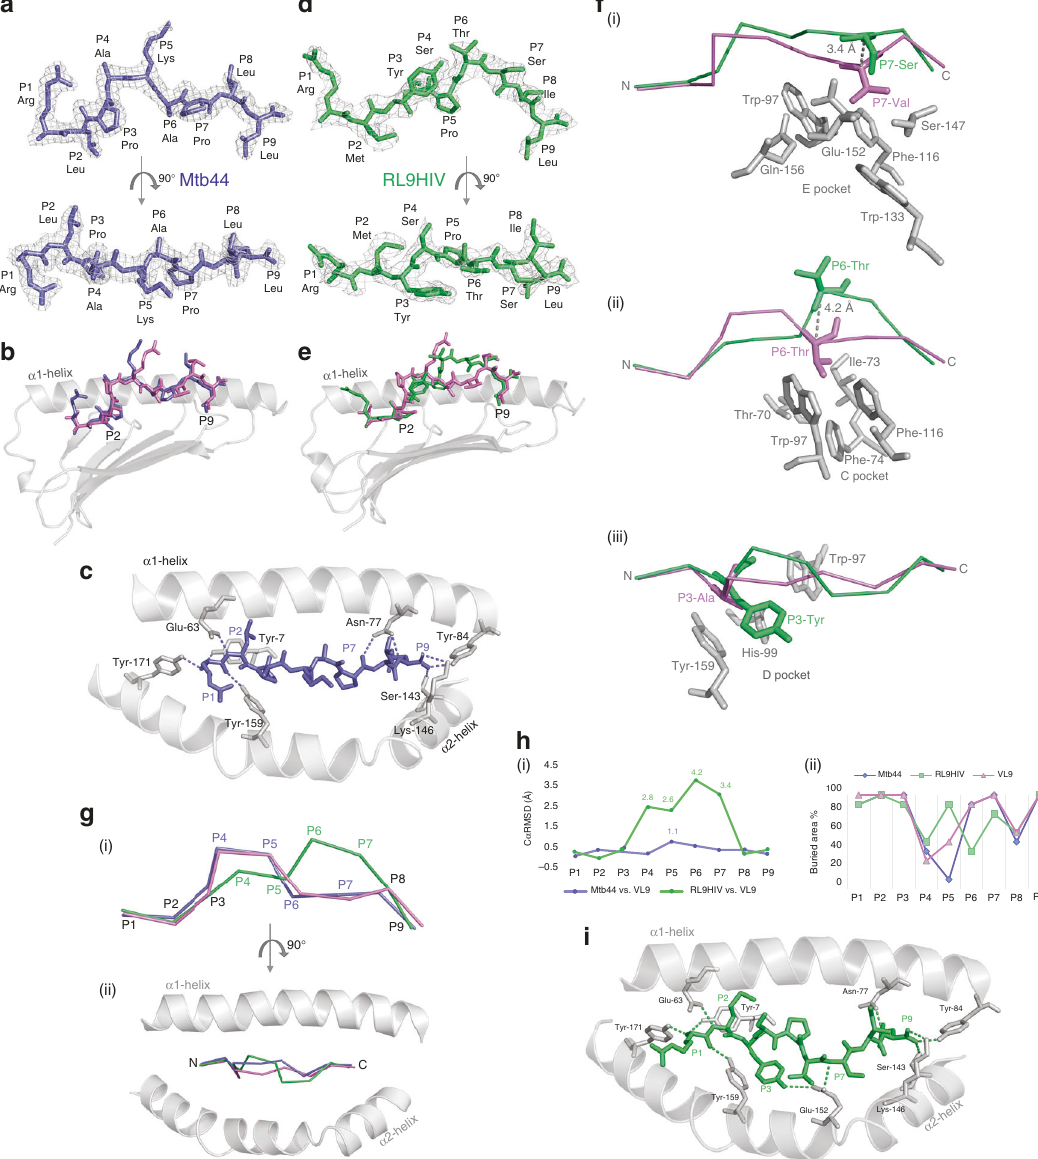
Fig. 2 Structural analysis of HIV- and Mtb-derived peptide-bound HLA-E*01:03 complexes. a Mtb-derived Mtb44 peptide (RLPAKAPLL) visualised as sticks in purple-slate side-on and from above with electron density overlaid in grey mesh and HLA-E*01:03 HC + β 2M omitted for clarity. (All electron density contoured at 1 sigma.) b Alignment of Mtb44 (purple-slate) and canonical VL9 (VMAPRTVLL) (violet) peptides depicted as sticks in the peptide binding groove displayed in grey cartoon with the omission of the α -2 helix for clarity. c Intermolecular Mtb44 peptide-HC hydrogen-bonding network visualisation. Peptide and HC-derived bonded residues displayed as solid sticks and H-bonds depicted as dashed lines (purple-slate). Peptide binding groove displayed as grey cartoon with the β -sheet fl oor omitted for clarity. d HIV-derived epitope “ RL9HIV ” (RMYSPTSIL) (lime green) in grey mesh electron density visualised side-on and from above with peptide binding groove omitted for clarity. e Alignment of RL9HIV (lime green) and canonical VL9 (violet) peptides depicted as sticks in the peptide binding groove with the α 1 helix and β -sheet fl oor displayed in grey cartoon and the α 2 helix omitted for clarity. f ( i ) E, ( ii ) C and ( iii ) D pocket visualisation for RL9HIV (lime green) superposed to VL9 (violet) with pocket-forming residues derived from the heavy chain of the RL9HIV-HLA-E complex depicted as grey sticks. Distances between the superposed peptide C α atoms shown as grey dashed lines. g C α backbone alignment of Mtb44, RL9HIV and VL9 peptides visualised side-on ( i ) and from above ( ii ) with peptide binding groove α 1 + 2 helices depicted in grey cartoon. h ( i ) Distance in Å between superposed C α atoms of Mtb44 versus VL9 and RL9HIV versus VL9 with peptide residue position along the x axis and distance on the y axis. ( ii ) Buried residue area percentage for Mtb44, RL9HIV and VL9 peptides with residue position along the x axis and buried area % on the y axis. i Intermolecular RL9HIV peptide-HC hydrogen-bonding network visualisation. Peptide and HC-derived bonded residues displayed as solid sticks with H-bonds depicted as dashed lines (lime green). Peptide binding groove displayed as grey cartoon with the β -sheet fl oor omitted for